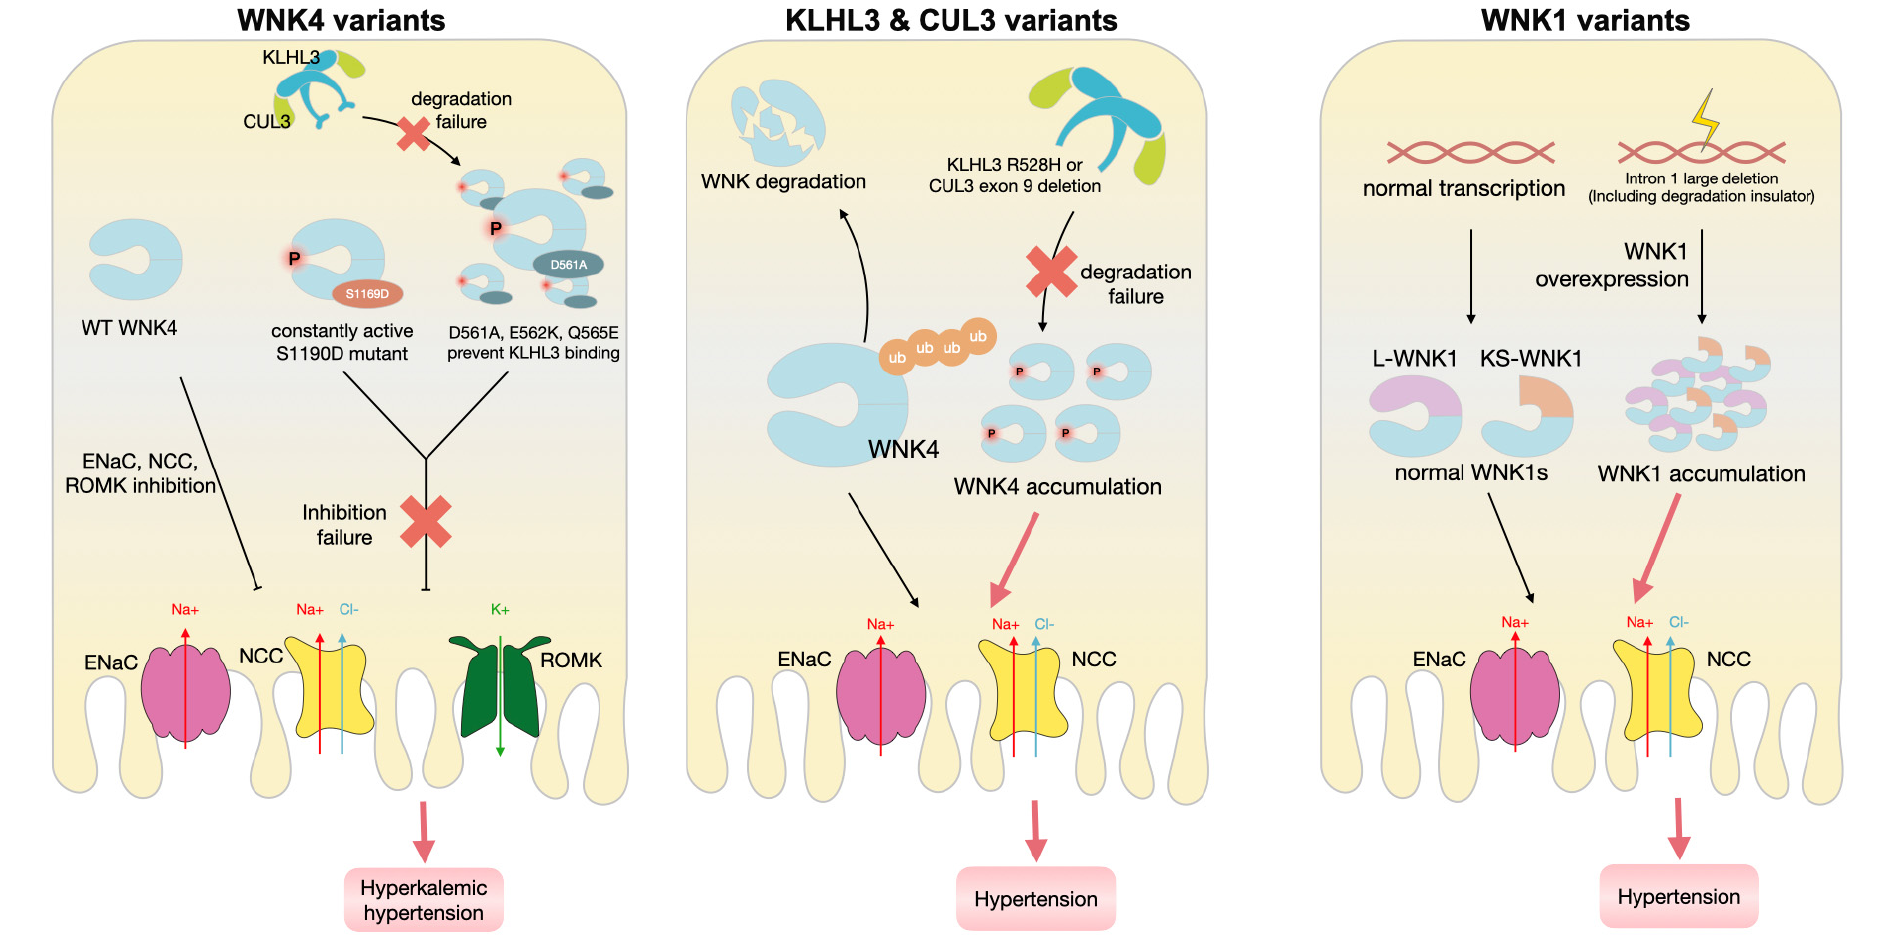
Figure 2. Pathophysiological changes induced by the genetic variants of WNK signaling pathway on the regulation of hypertension and/or electrolyte homeostasis via modulating ion channels on the nephron epithelium. Thick red arrow: pathological result of corresponding mutation; thin black arrow: result of normal physiological condition.